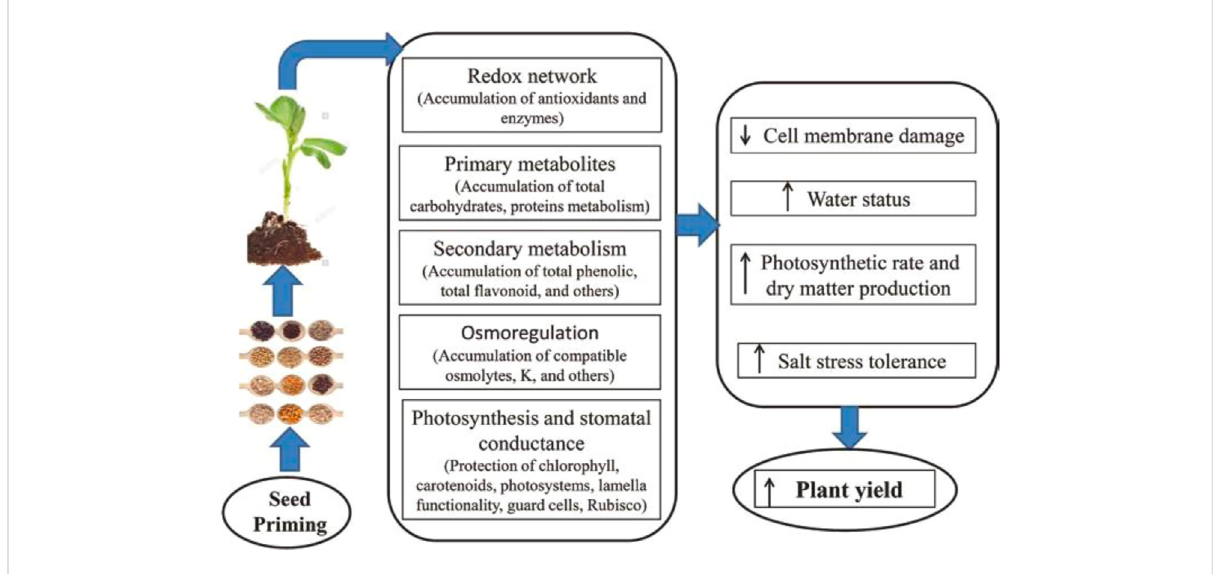
FIGURE 5 Schematic diagram showing the impact of seed priming on physical, chemical, and biological processes (Abdelhamid et al.,